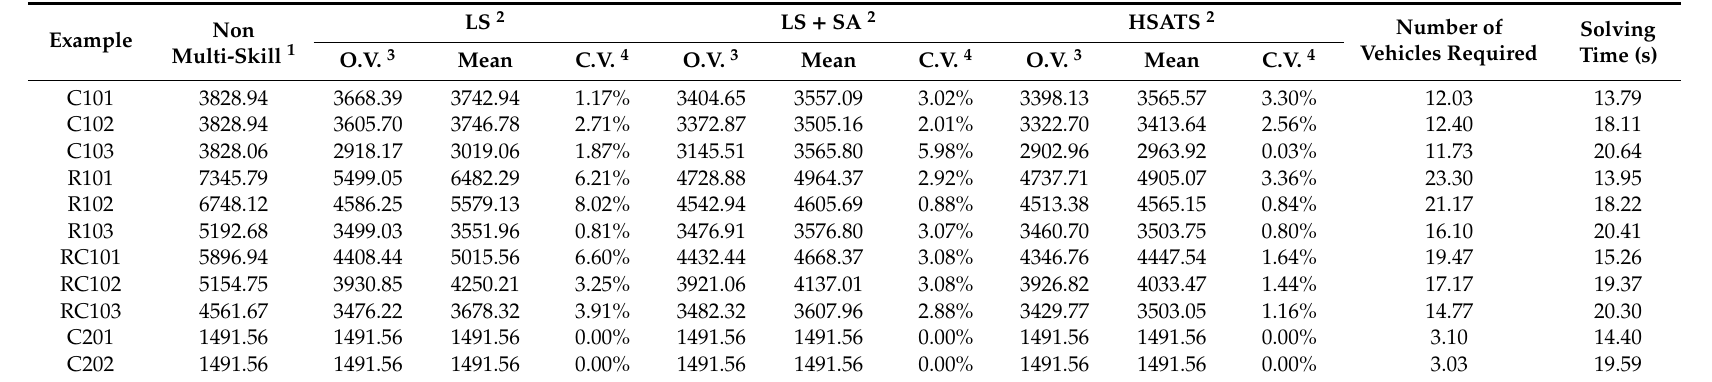
Table 11. Total cost in di ff erent algorithm